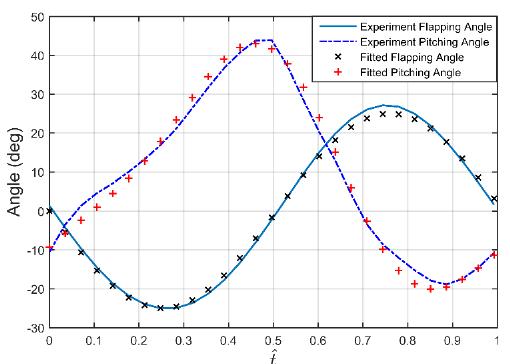
Figure 10. Measured and fitted test data of flapping and pitching angles in one cycle ( 𝑡̂ refers to the non-dimensional time normalized by flapping cycle).